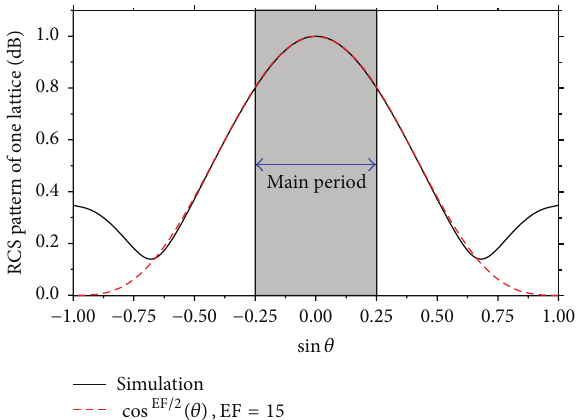
Figure 6: RCS pattern of one lattice composed by 12 × 12 “0” or “ 𝜋 ” elements.